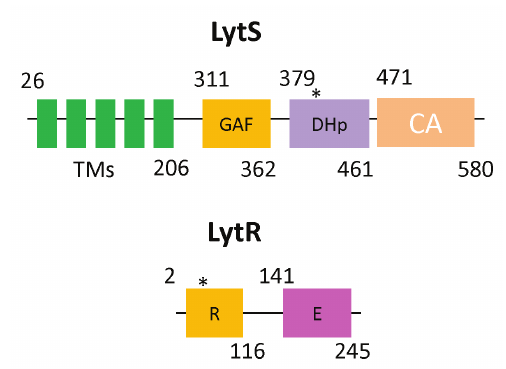
Figure 1. Domain organizations of LytS (P60612) and LytR (P60609) as predicted by InterPro (EMBL-EBI) (“TM” stands for transmembrane regions; “*” denotes the phosphorylation sites, His-390 in LytS and Asp-53 in LytR; “R” stands for receiver domain; “E”, stands for the effector domain).